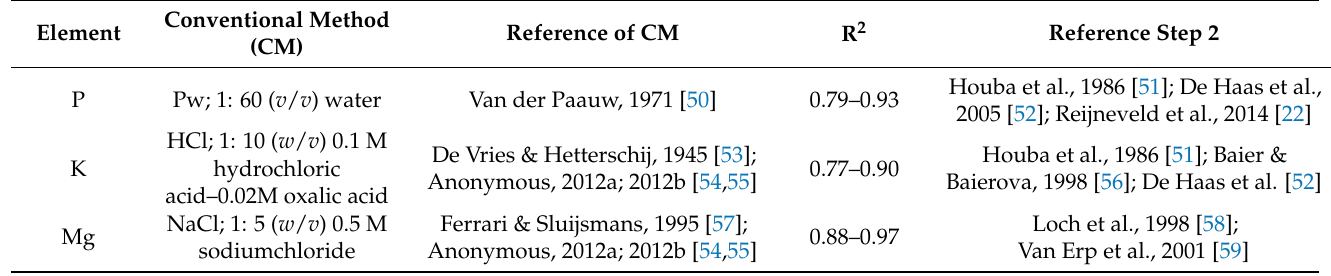
Table 3. Soil characteristic (element), conventional method, reference of conventional method, explained variance of the relation between the conventional methods (CM) and the broad-spectrum soil tests (0.01 M CaCl 2 and NIRS), and their references (step 2). The determination coefficient (R 2 ) gives the relation between the CM and the broad-spectrum soil tests. The ‘reference’ in step 2 shows where these results have been